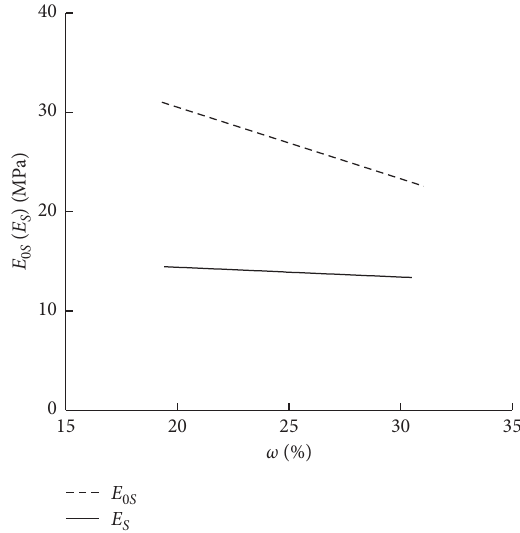
Figure 1: Curves of E